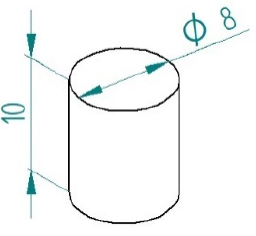
Figure 2. Shape and size of sample.